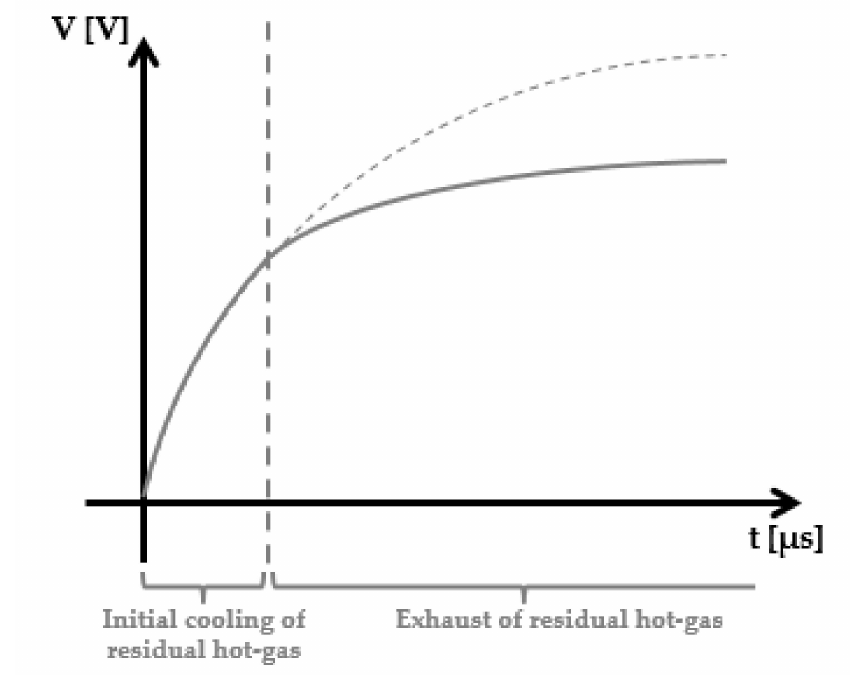
Figure 3. Typical dielectric recovery voltage V–t